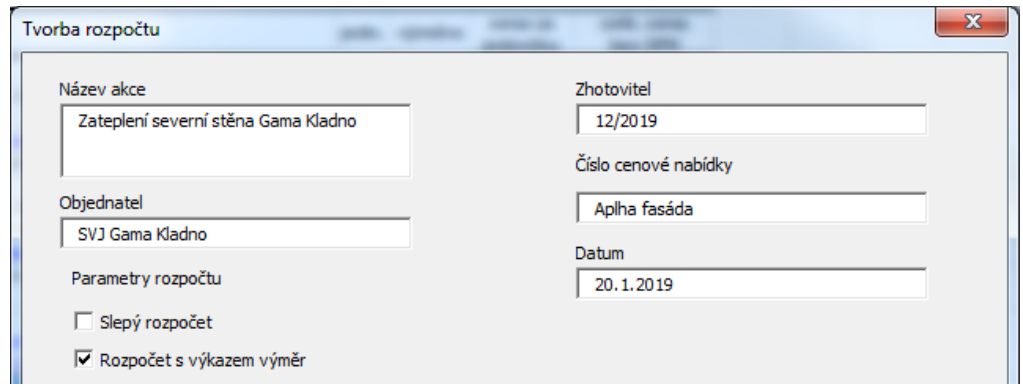
Figure 6: Uživatelský formulář pro generaci rozpočtu (zdroj: autor)